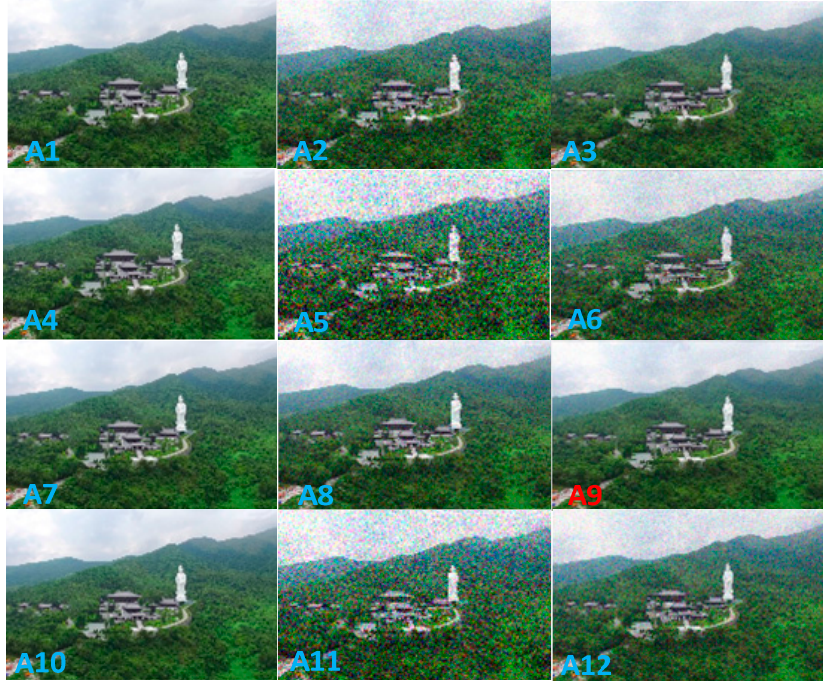
Figure 17. Aerial images: model performance trained with 180 × 180 image size. ( A1 , A4 , A7 , A10 ) Original images; ( A2 ) noisy image with 64 × 64 image size and σ = 10 ; ( A3 ) denoised image with 64 × 64 image size and σ = 10 ; ( A5 ) noisy image with 64 × 64 image size and σ = 15 ; ( A6 ) denoised image with 64 × 64 image size and σ = 15 ; ( A8 ) noisy image with 180 × 180 image size and σ = 10 ; ( A9 ) denoised image with 180 × 180 image size and σ = 10 ; ( A11 ) noisy image with 180 × 180 image size and σ = 15 ; ( A12 ) denoised image with 180 × 180 image size and σ = 15 .